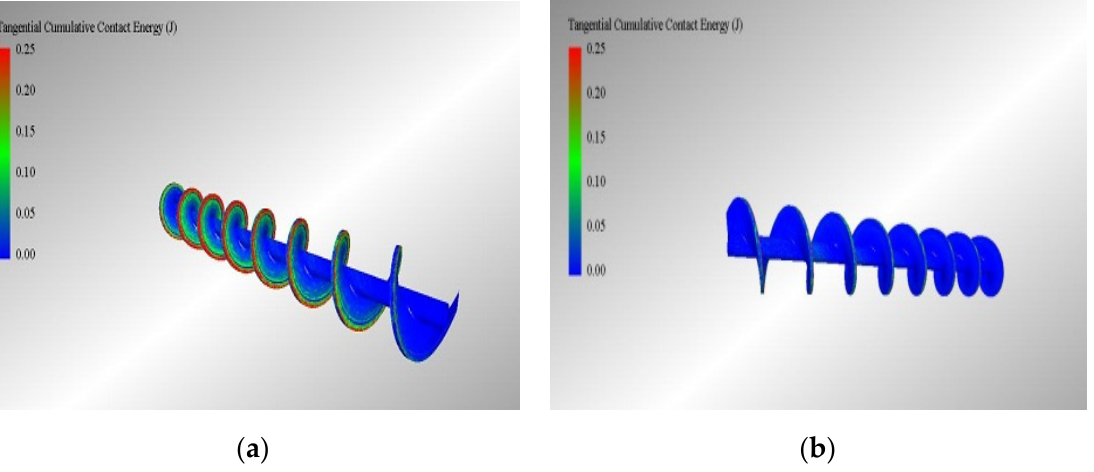
Figure 6. Distribution of working 20 s wear of helical blade, ( a ) Wear of blade working surface, ( b ) Wear of blade non-working surface.